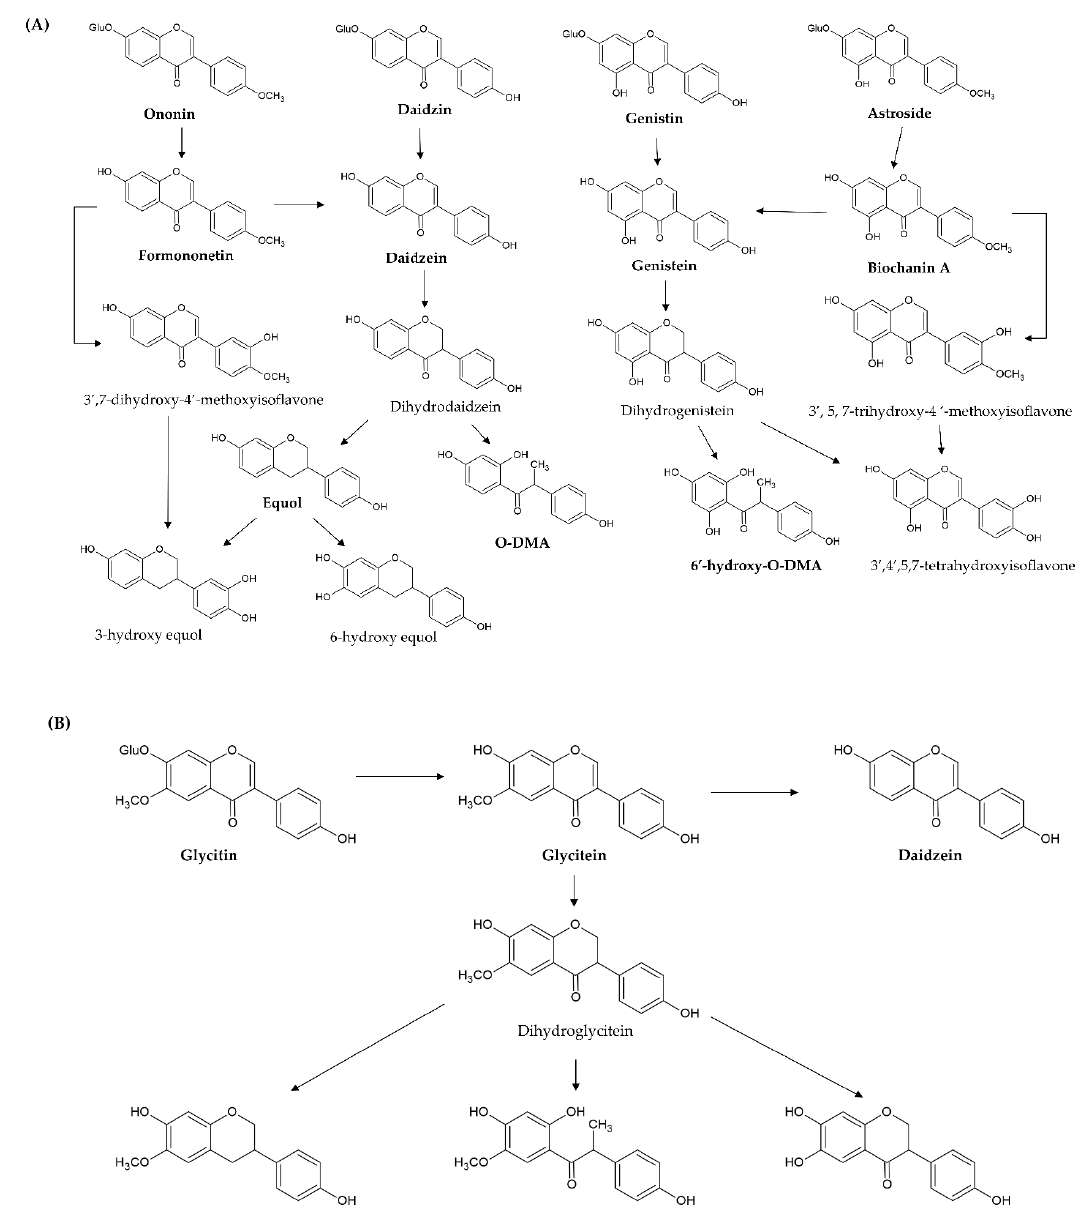
Figure 4. Proposed metabolic pathway of novel simple O-substituted isoflavones (( A ) daidzin, daidzein, genistin, genistein, biochanin A, and formononetin; ( B ) glycitin and glycitein). O-DMA, O- desmethylangolensin.